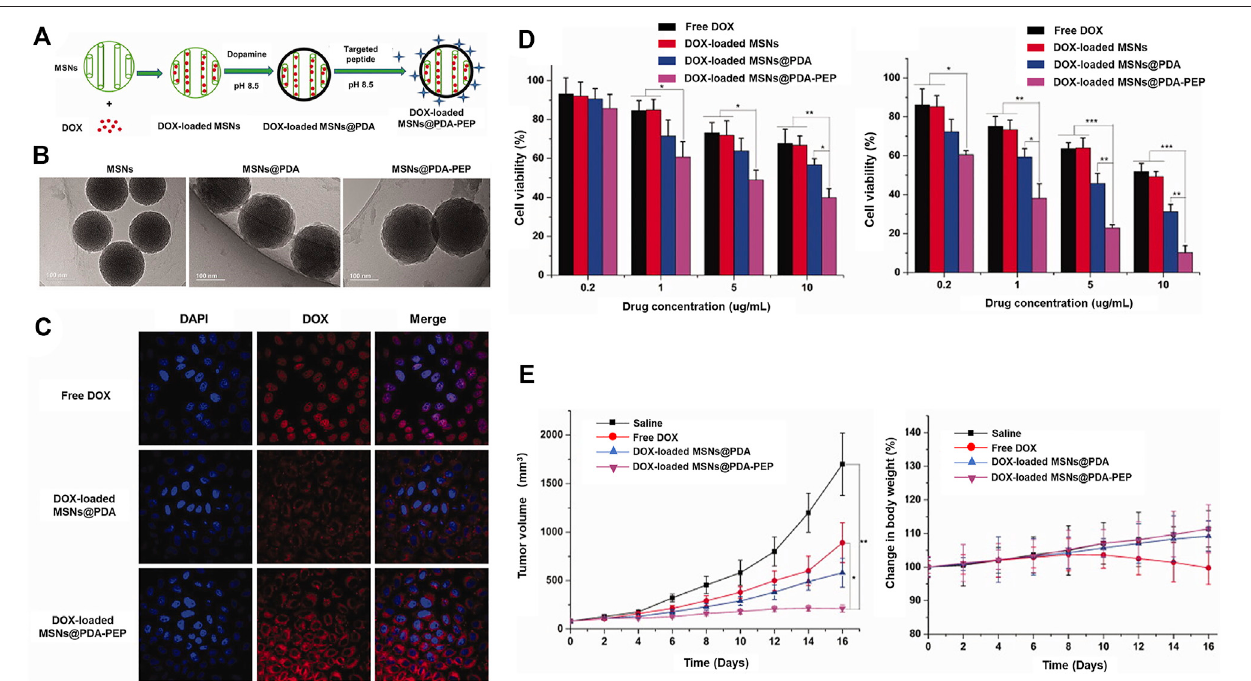
FIGURE 6 | Utility of MSNs@PDA-PEP as a drug carrier for targeted BC therapy. (A) Schematic representation of the preparation techniques of DOX-loaded MSNs@PDA-PEP. (B) TEM of different NPs. (C) CLSM imaging of HT-1376 cells treated with different drugs for 2 h. (D) Viability of HT-1376 cells treated with different formulations of drugs after 24 and 48 h. (E) Tumor growth curves and weight changes of tumor-bearing nude mice treated with different formulations of drugs. Reproduced with permission from (Wei et al., 2017).